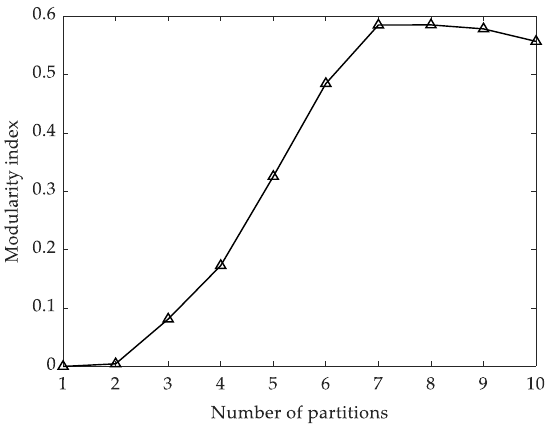
Figure 7. Partitional modularity index.